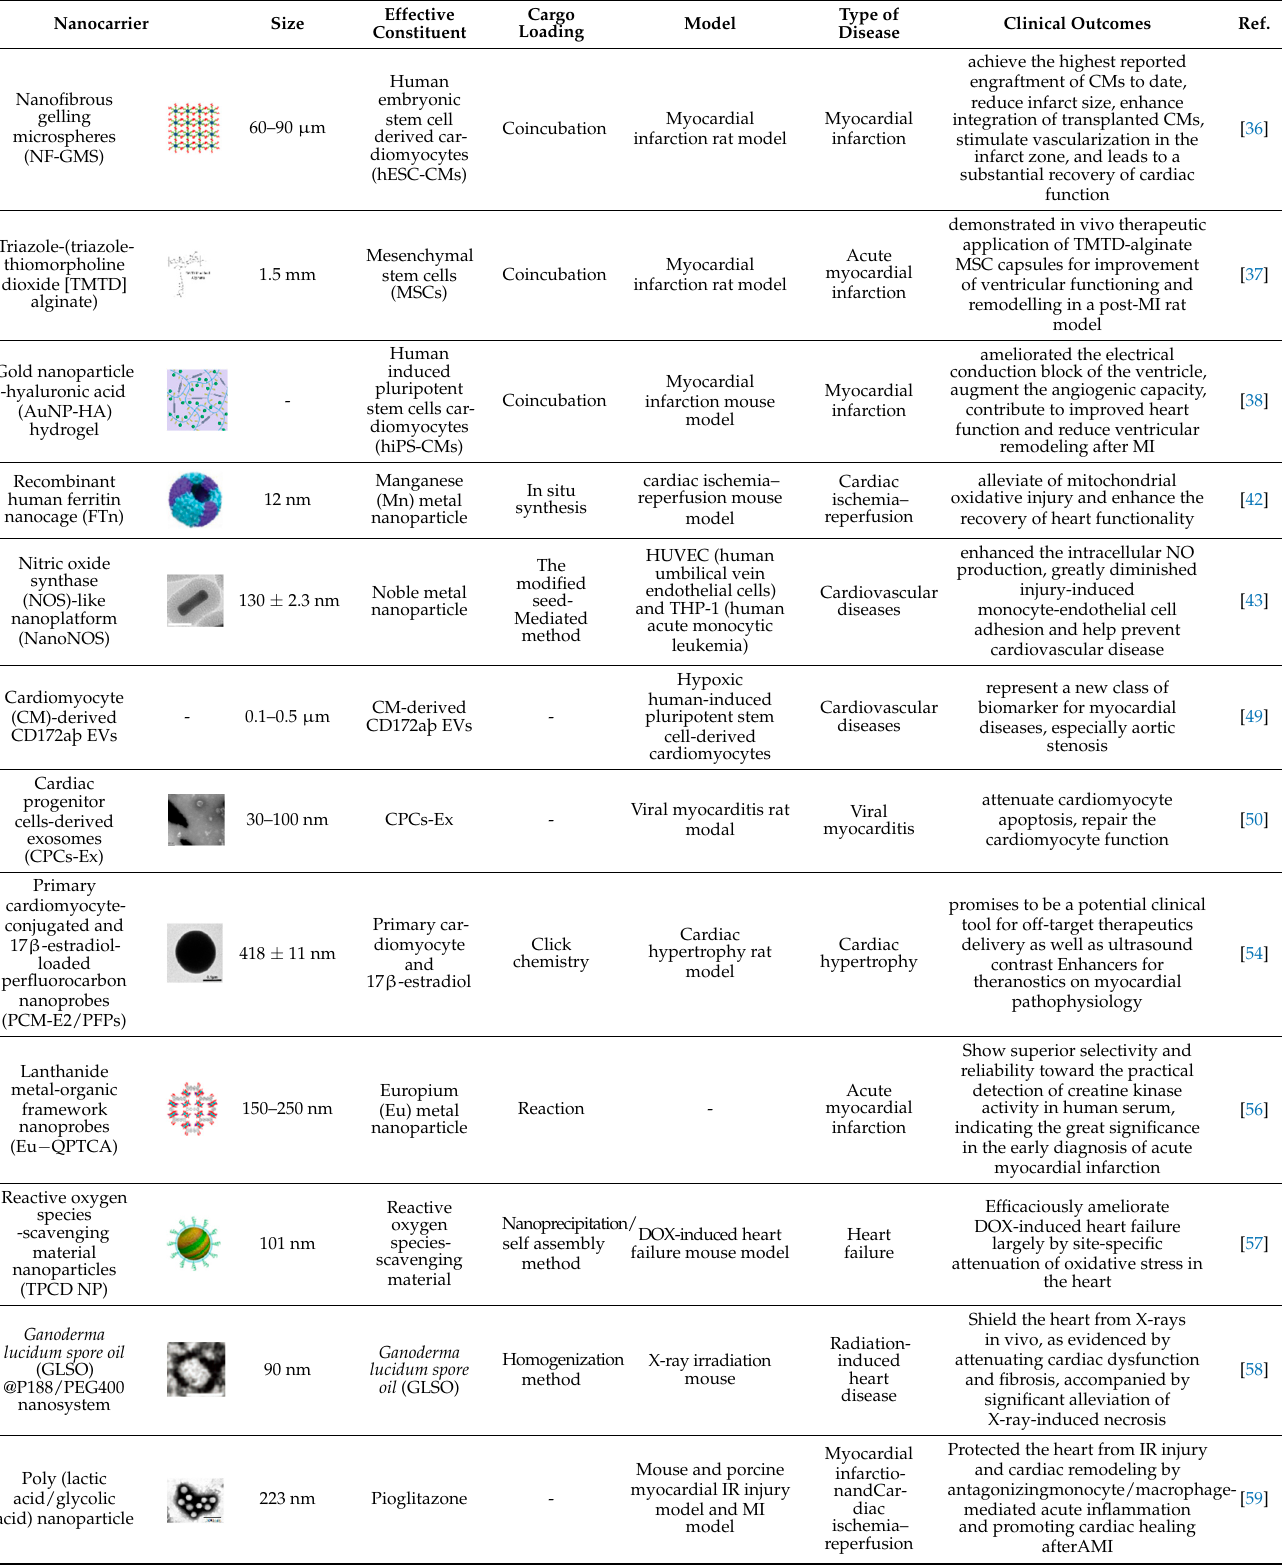
Table 1. The application of functionalized nanomaterials in myocardial repair.